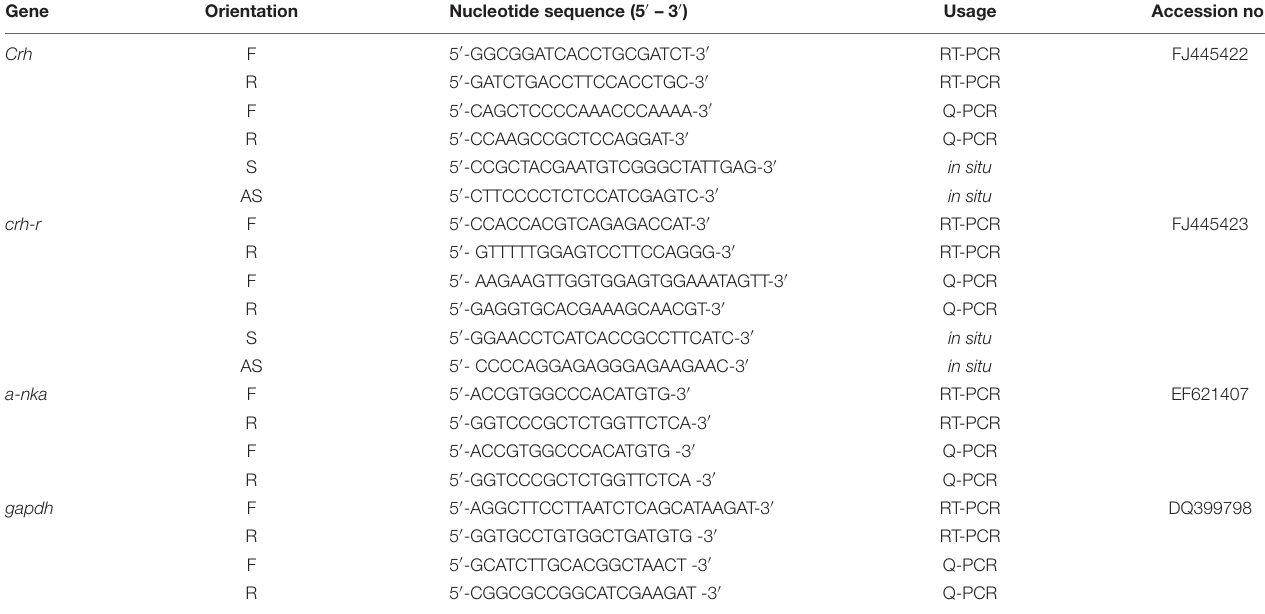
TABLE 1 | List of primers used for RT-PCR, Q-PCR, and in situ hybridization analysis. Gene Orientation Nucleotide sequence (5 (cid:48) – 3 (cid:48) ) Usage Accession no.